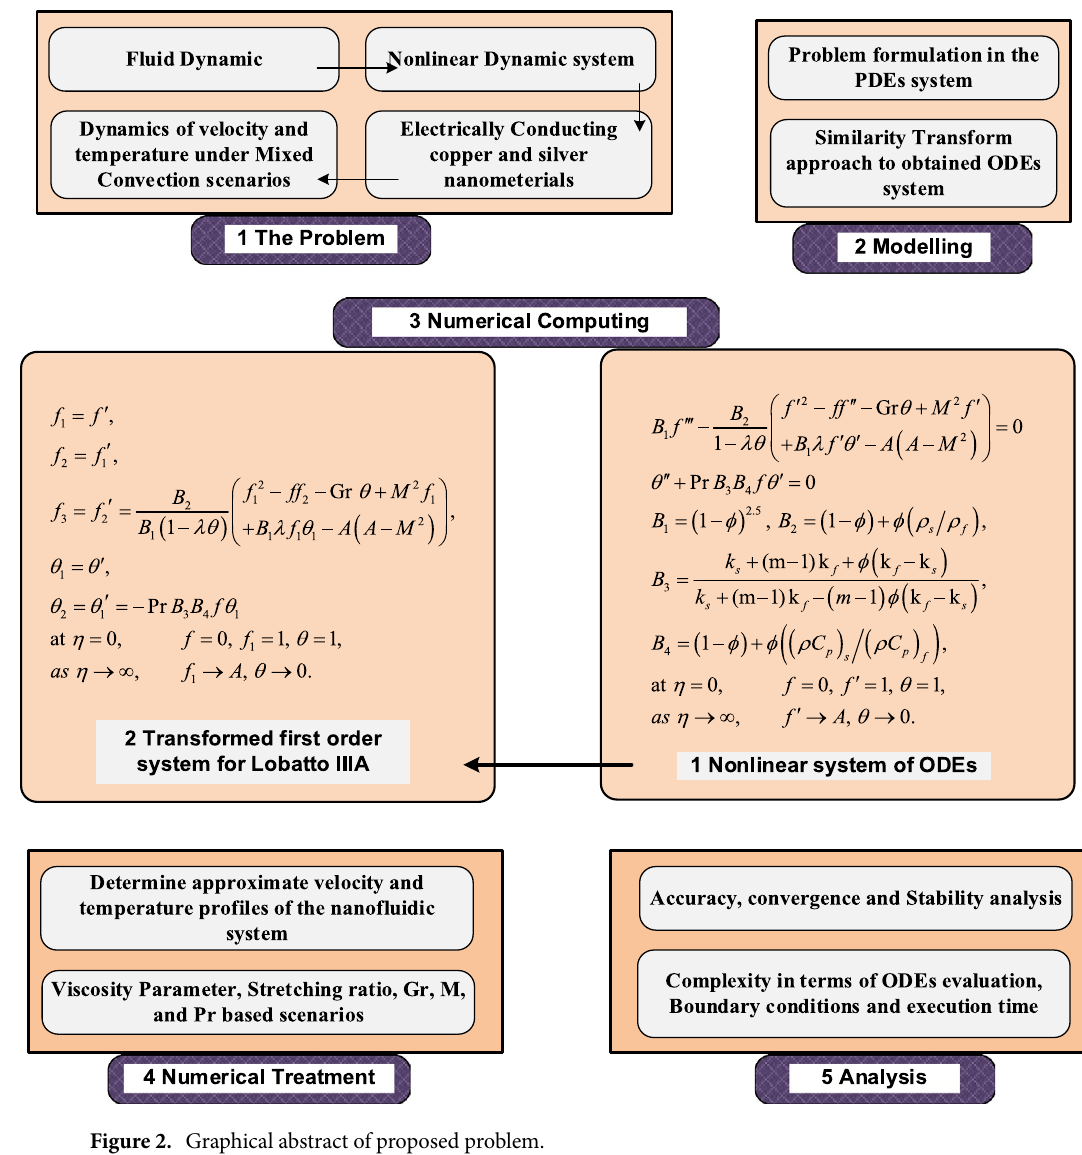
Figure 2. Graphical abstract of proposed